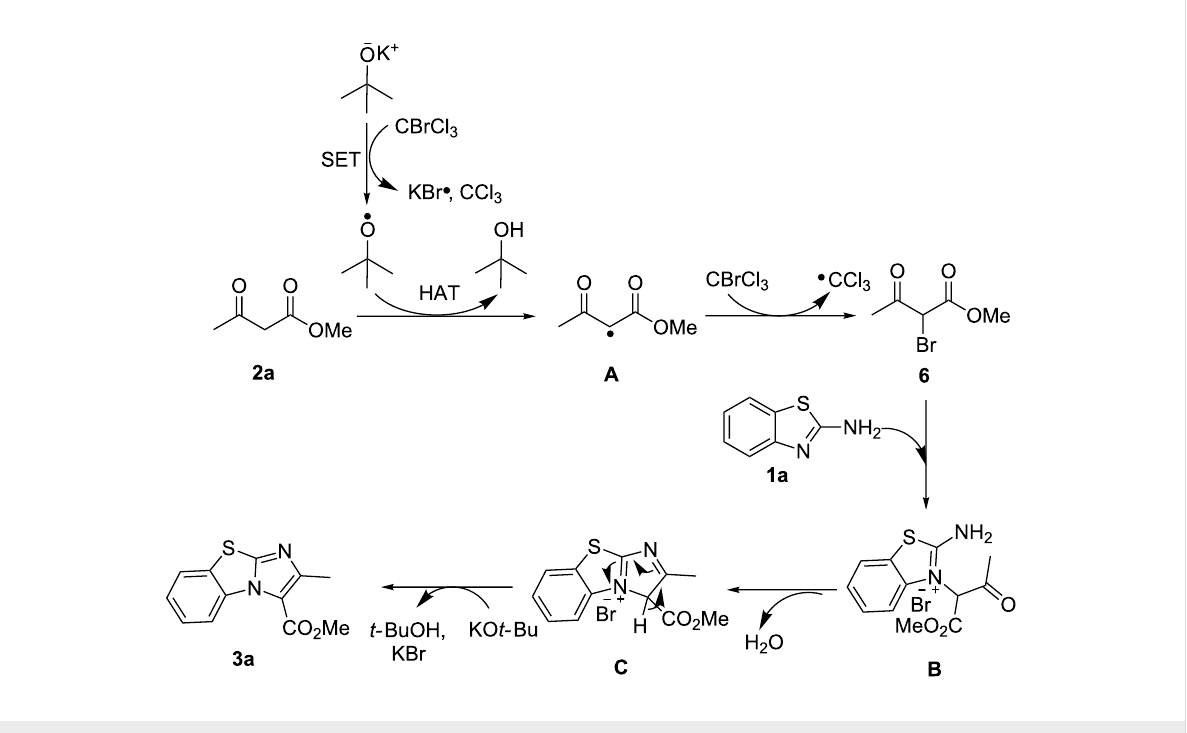
Figure 1: Proposed mechanism (benzo[ d ]imidazo[2,1- b